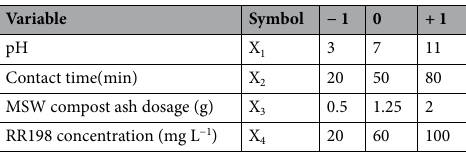
Table 2. Experimental ranges and levels of the process parameters used in the Box–Behnken